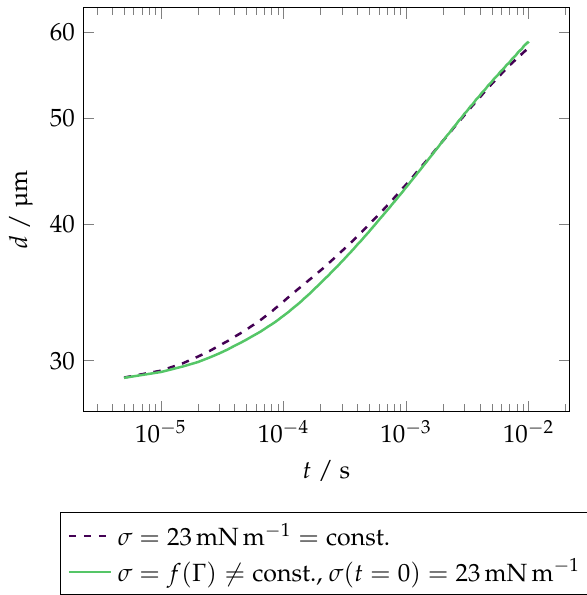
Figure 5. Wetted diameter over time for a droplet with insoluble surfactant in comparison with a droplet with constant, but initially identical surface tension.